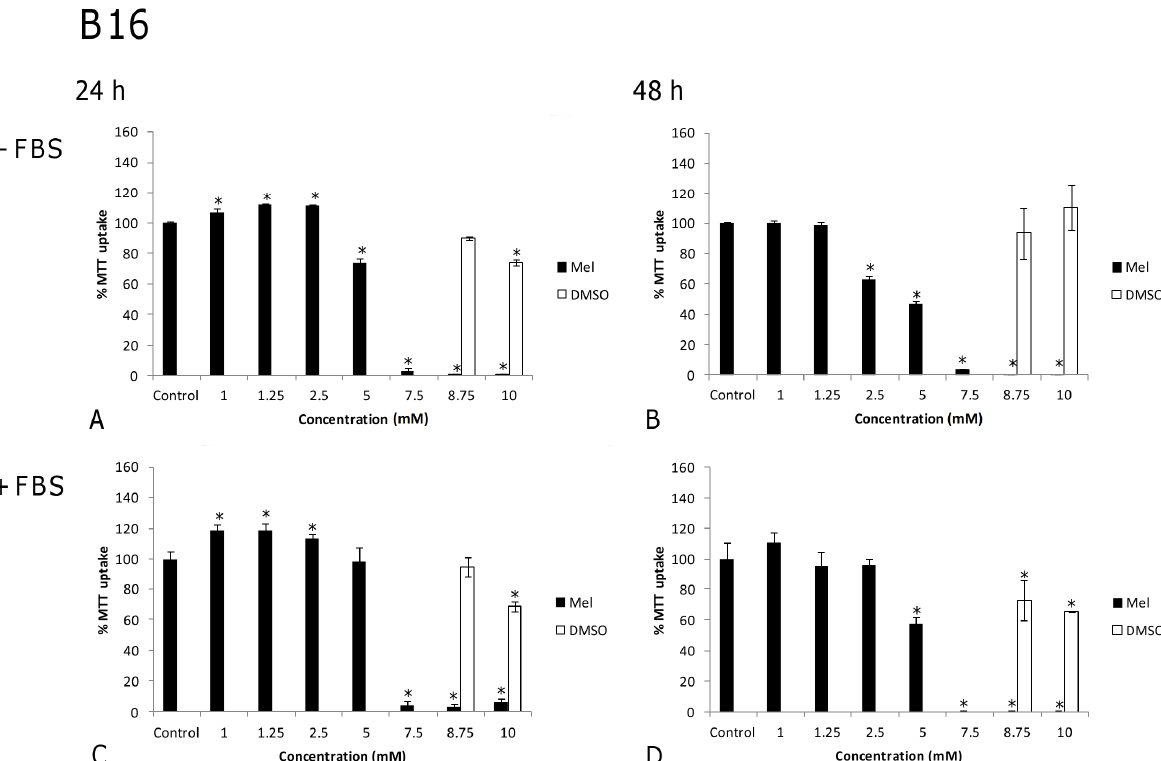
Figure 3. Melanoma cell line (B16): Effects of melatonin on cell viability (expressed as the percentage of MTT uptake with respect to the untreated control), in a high concentration range, in the absence ( A and B ) or the presence ( C and D ) of fetal bovine serum (FBS) after 24 ( A and C ) and 48 h ( B and D ) of treatment. DMSO vehicle controls were performed for each melatonin concentration, although for terms of clarity only the two highest concentrations are represented. Statistically significant differences compared to controls are marked with asterisks. (* indicates p < 0.05, ANOVA followed by Dunnett’s post hoc